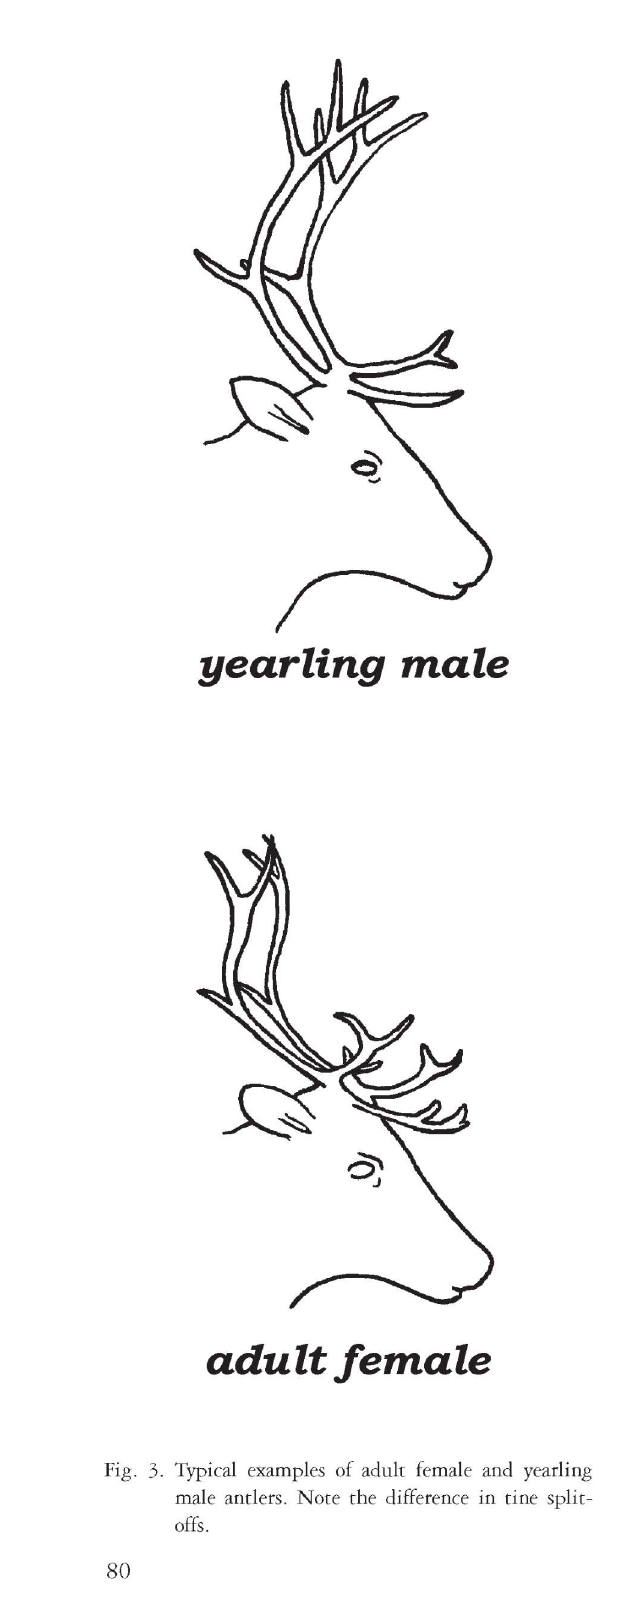
Fig. 3. Typical examples of adult female and yearling male antlers. Note the difference in tine split-